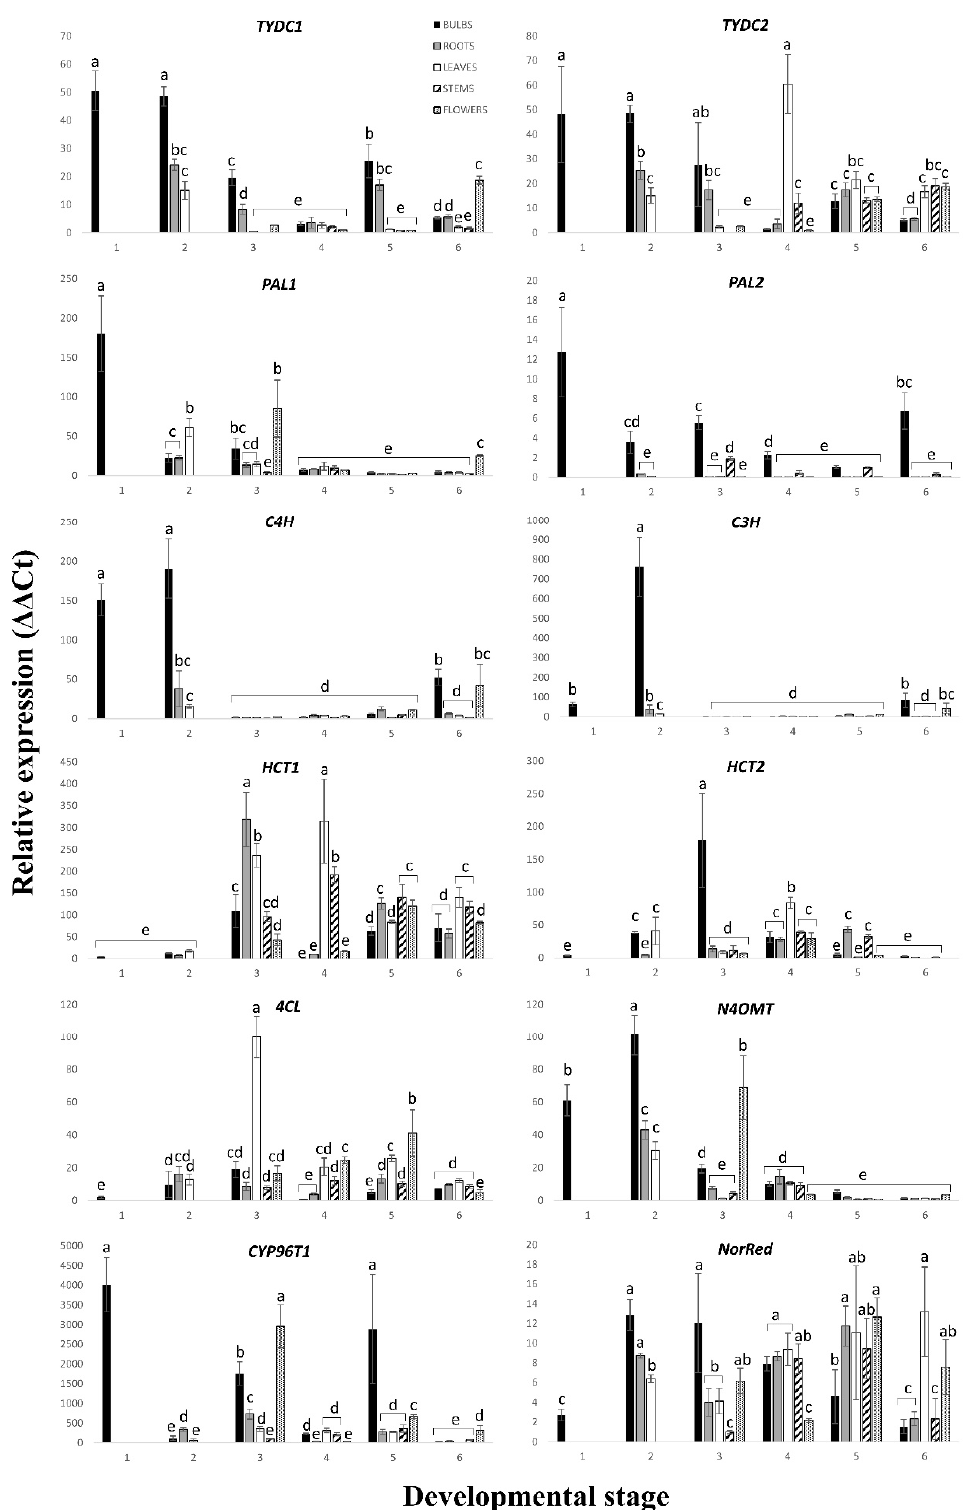
Figure 3. Expression profiles of twelve genes involved in Amaryllidaceae alkaloid biosynthesis obtained by reverse transcription quantitative real-time PCR analysis of di ff erent parts (bulb, roots, leaves, stem and flowers) at six developmental stages of Narcissus papyraceus . The graphs are plotted using normalized ∆∆ C T values scaled to the lowest value. Each graph shows the expression level of the gene indicated above the graph. The gene for histone was used as a reference gene. The gene